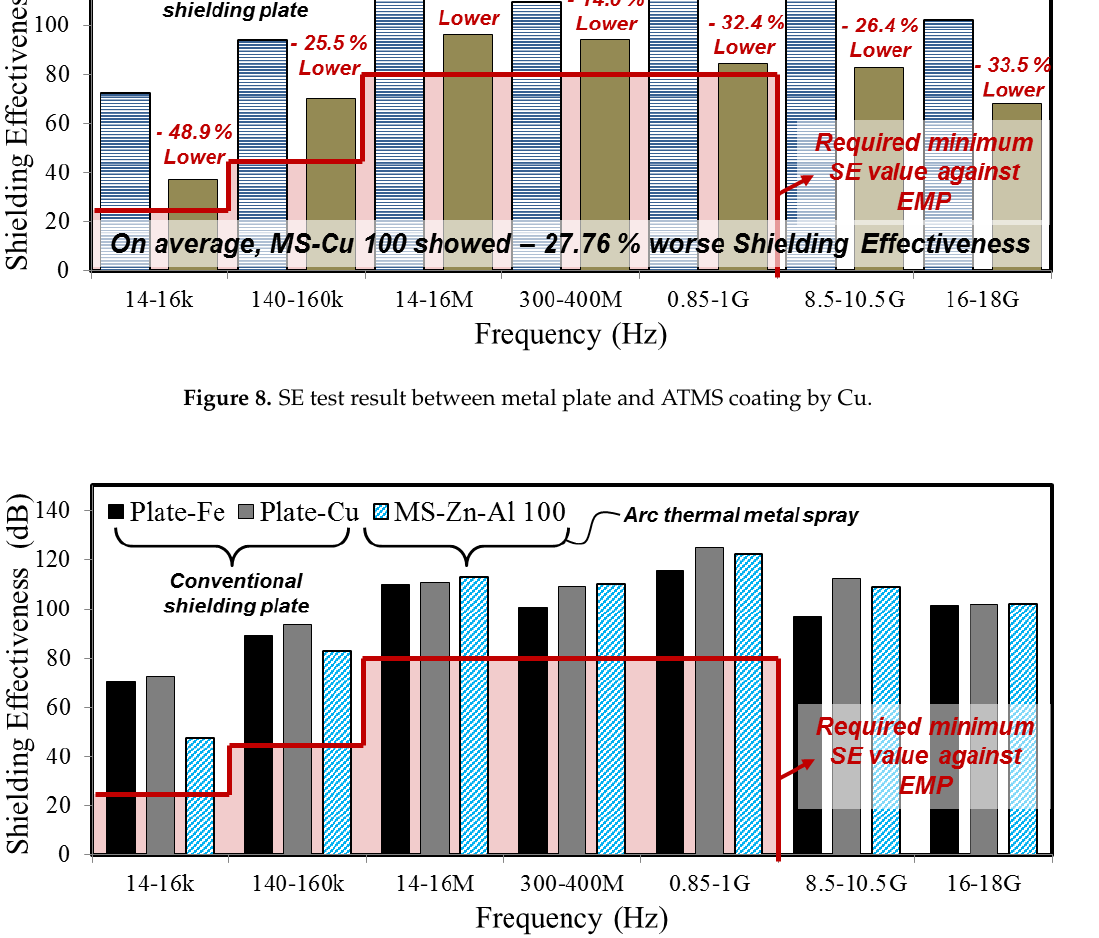
Figure S1: Shielding principle of metal material against electromagnetic wave, Figure S2: Coating thickness and error bar of Zn-Al and Cu coating, Figure S3: The required shielding effectiveness in terms of EMP shielding room, Figure S4: Schematic diagram of SE test for specimens, Figure S5: Cross-sectional diagram of SE test for installation of specimens, Table S1: Frequency range of SE test.